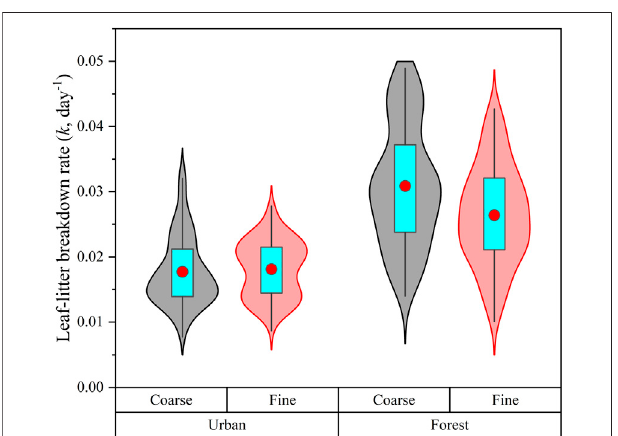
FIGURE2| Violinplotofleaf-litterbreakdownrate( k ,day − 1 )inurbanand forest streams. The box plots summarize the distribution of all values for each — — type of stream. Box plots indicated interquartile ranges (box part), 25th and 75th percentiles (lower and upper error bars), and mean values (red circles in the